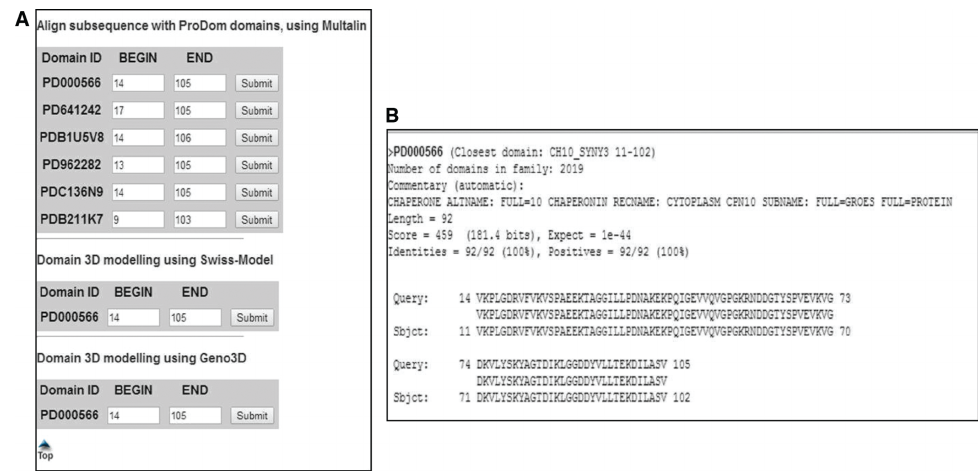
Figure 3: Predicted secondary structure of our protein of interest. (A) The output of ProDom searches against the query protein P9303_05031. It is clear from that PD000566 is the first best hit in the ProDom search. (B) Represents the alignment of the PD000566 with our query protein P9303_05031. From the above alignment it is clear that from residue 14 to 105 the entire amino acids stretch is conserved between PD000566 and the query